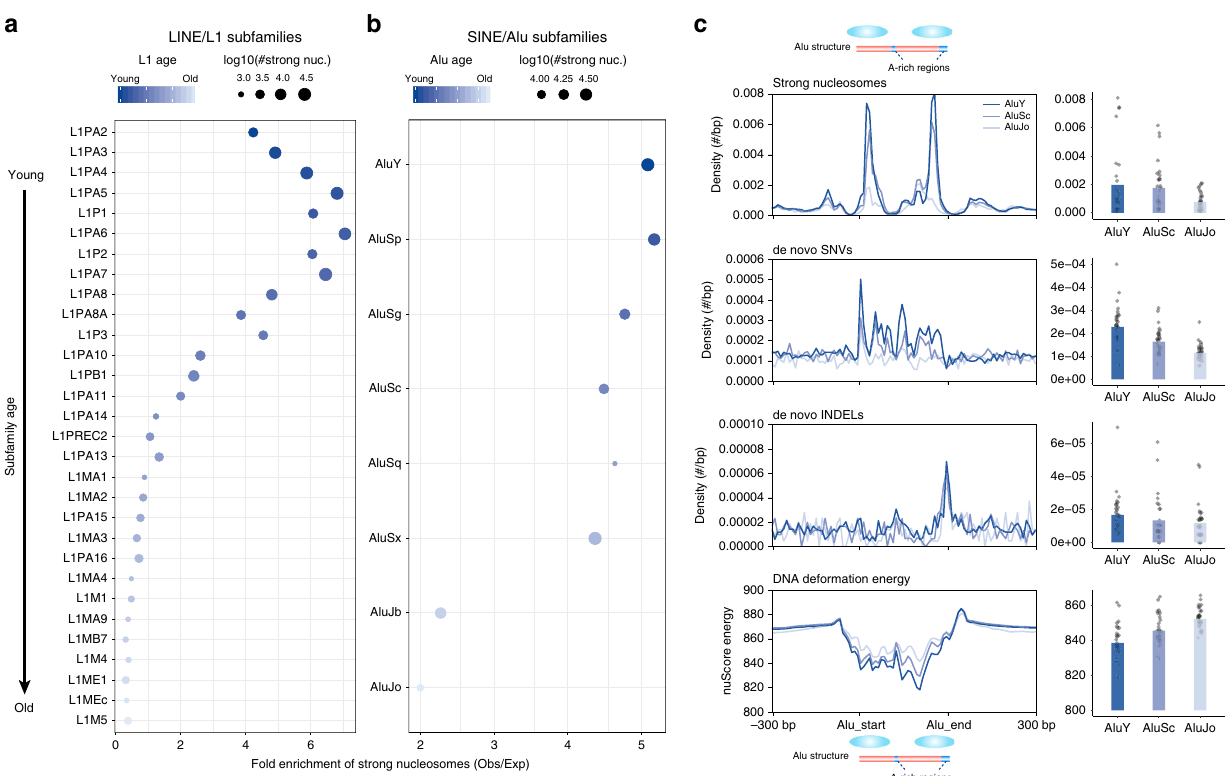
Fig. 5 Strong nucleosomes are enriched for evolutionarily young LINE and SINE elements. a Fold enrichment of strong-nucleosome occurrence in L1 subfamilies. The top 30 abundant subfamilies are shown ordered by evolutionary age. Dot sizes depict the numbers of strong nucleosomes and color- scale indicates the subfamily age. b Same as a but for Alu elements (only major subfamilies with age information presented here). c Densities of strong- nucleosome dyads, de novo SNVs, and de novo INDELs along the Alu sequences and fl anking regions, grouped by Alu subfamilies of different ages. Bar plots show the average densities for all Alus of different subfamilies on the right, with dots representing the values of Alu bins in the left meta-pro fi le panels. The bottom panel shows the average DNA deformation energies along Alu sequences estimated using nuScore. Pro fi les were plotted using Alu elements ≥ 250 bp and all elements were scaled up to a 300 bp region in the plots. Source data are provided as a Source Data fi